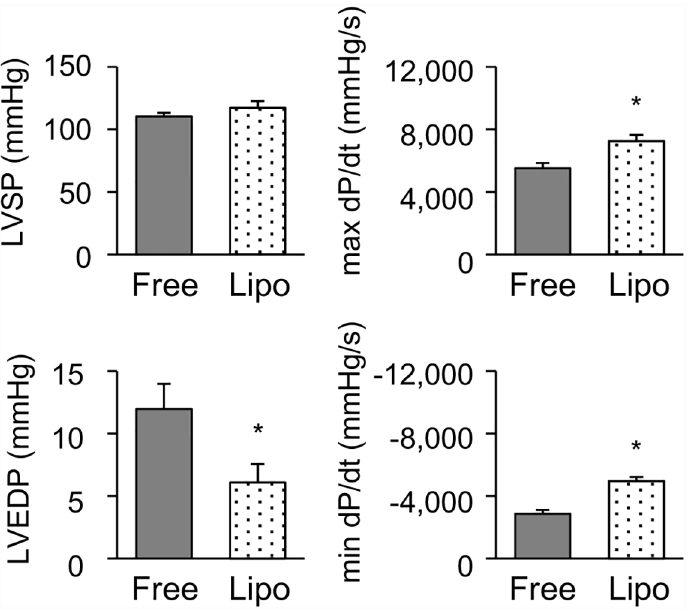
Fig 6. Effects of free and liposomal FK506 on hemodynamic parameters in the rat EAM model. Quantitative data of hemodynamic parameters including left ventricular systolic pressure (LVSP), left ventricular end-diastolic pressure (LVEDP), max dP/dt and minimum dP/dt. EAM rats were treated with free or liposomal FK506 (0.035 mg/kg) on days 14 and 17 after immunization (N = 6 and 9, respectively). Data are expressed as the mean ± SEM. * P < 0.05 versus the free FK506 treated